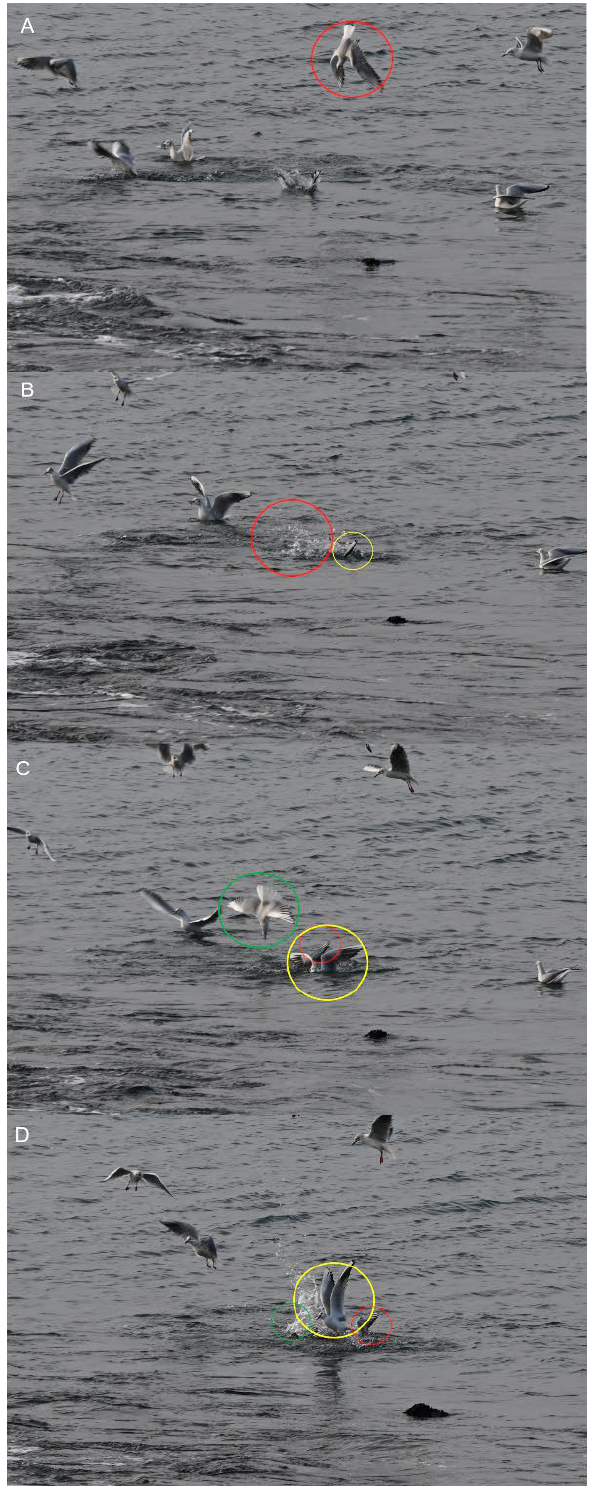
Figure 4. Motor sequence of three Chroicocephalus ridibundus closely preying on a fish shoal. ( A , B ) One individual plunges (red circle) toward the fish, while another begins to emerge (yellow circle). ( C , D ) An individual (green circle) plunges while another begins to emerge (red circle) and another (yellow circle) flies out of the water with the prey in its beak. Time between two frames: 0.01 s.